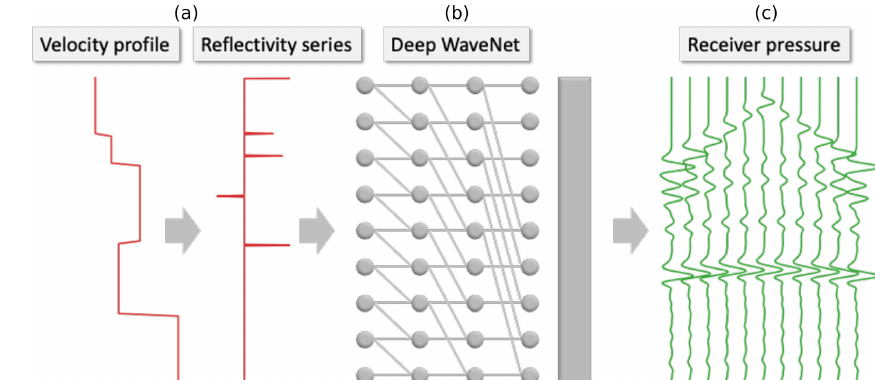
Figure 2. Our WaveNet simulation workflow. Given a 1-D Earth velocity profile as input (a) , our WaveNet deep neural network (b) outputs a simulation of the pressure responses at the 11 receiver locations in Fig. 1. The raw input 1-D velocity profile sampled in depth is converted into its normal incidence reflectivity series sampled in time before being input into the network. The network is composed of nine time- dilated causally connected convolutional layers with a filter width of two samples and dilation rates which increase exponentially with layer depth. Each hidden layer of the network has the same length as the input reflectivity series, 256 channels and a rectified linear unit (ReLU) activation function. A final causally connected convolutional layer with a filter width of 101 samples, 11 output channels and an identity activation is used to generate the output simulation.